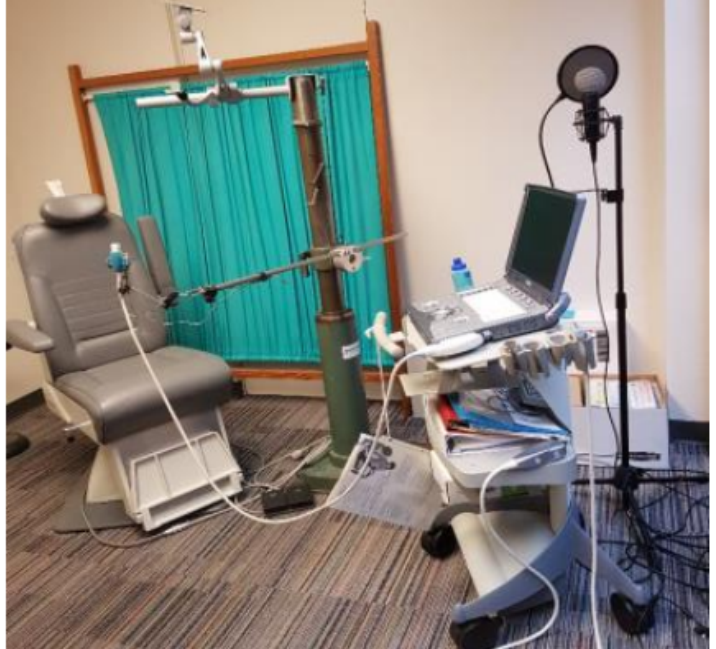
Figure 3. Ultrasound image acquisition system used in speech analysis. The system is also configured with a microphone and head-transducer stability system. The copyright for the ultrasound and head-transducer support system picture belongs to the author of this article, Khalid Al-hammuri